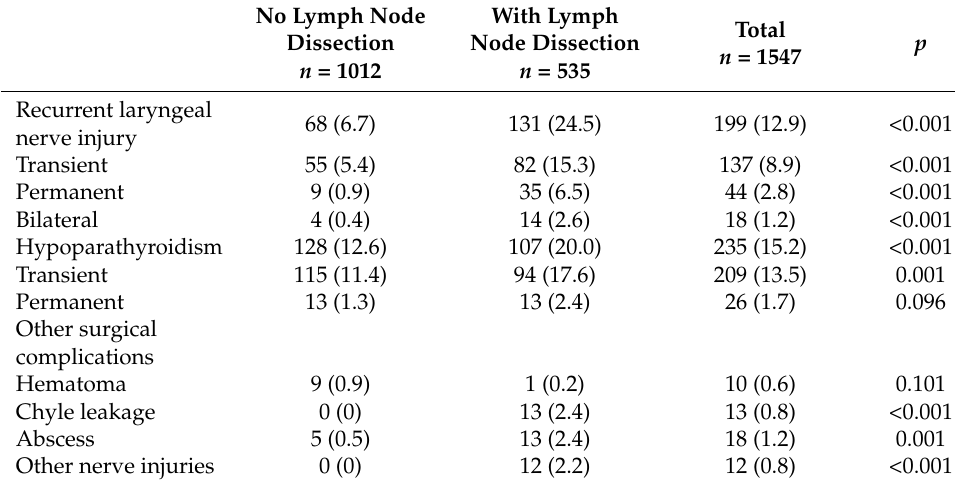
Table 2. Surgical complications in patients who underwent total thyroidectomy with or without lymph node dissection for thyroid